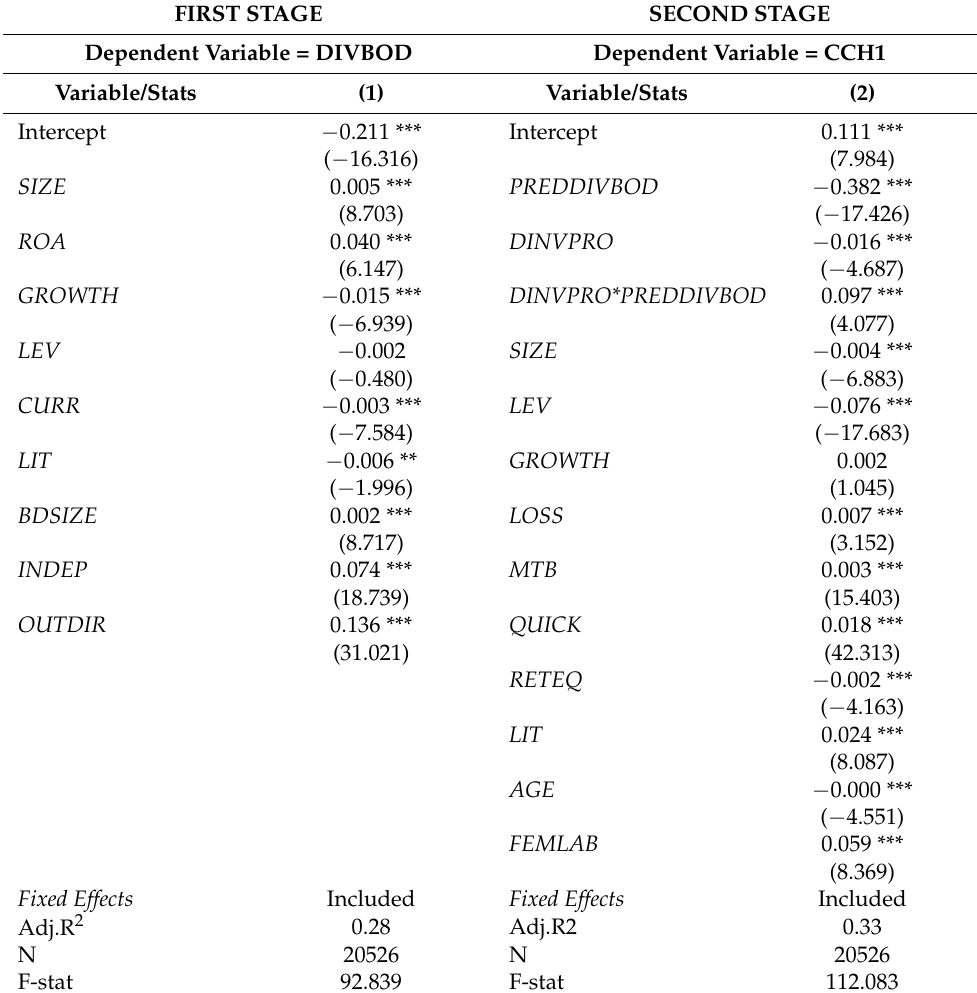
Table 3. Two-stage regression (2SLS) estimates of the effect of investor protection and board diversity on corporate cash